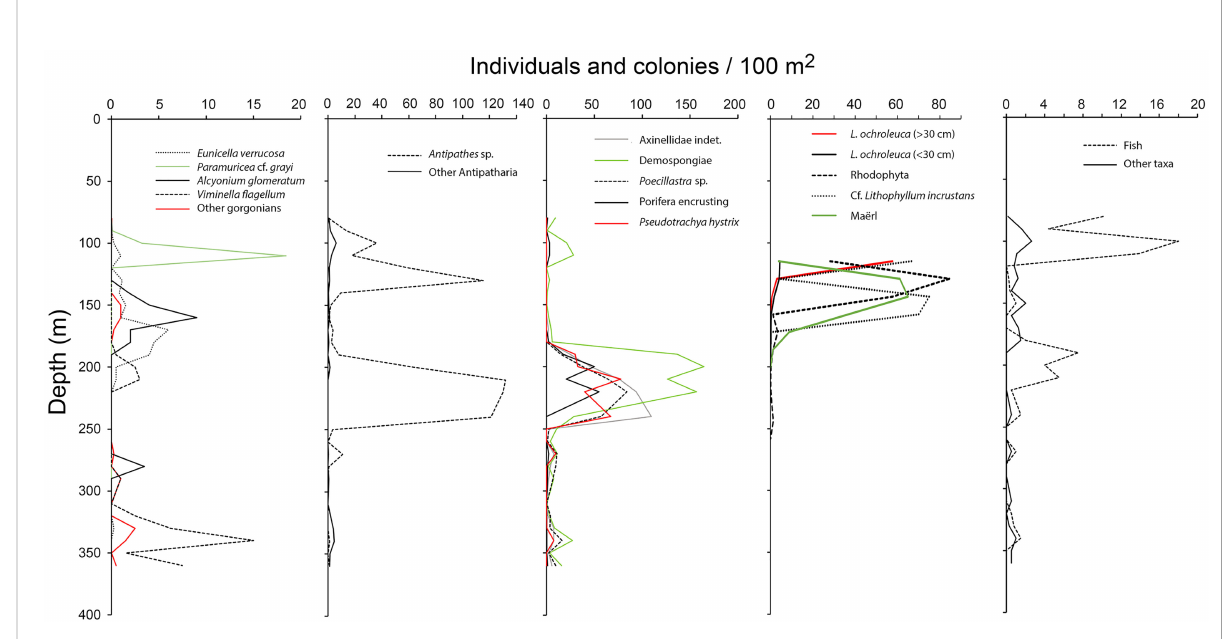
FIGURE 8 Bathymetric distribution of the abundance of dominant taxa. Lithophyllum and maërl is represented as percentage